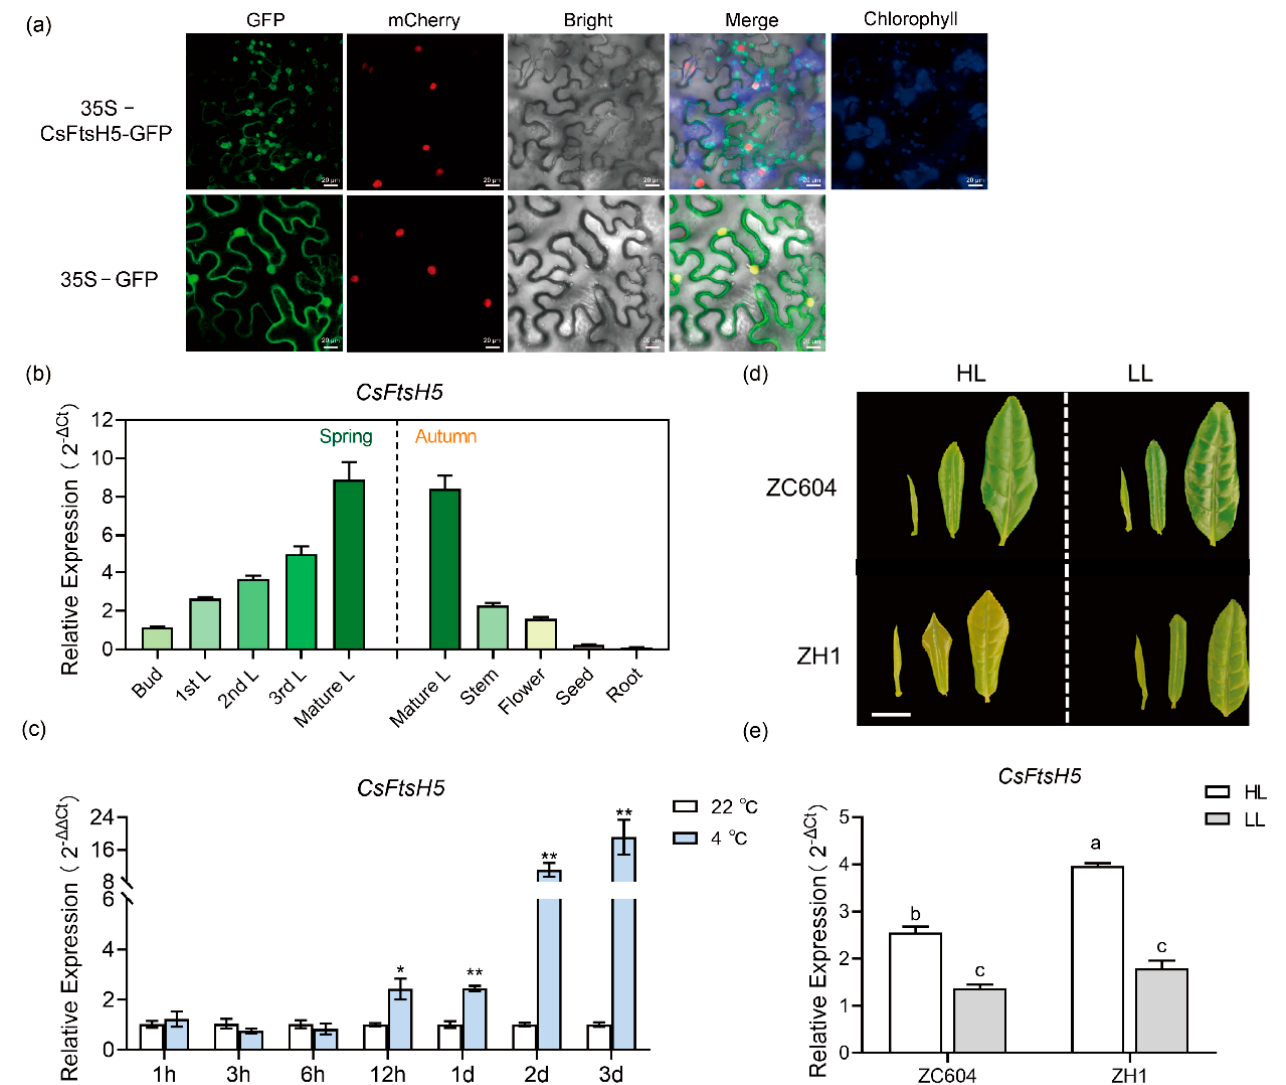
Figure 2. Expression profiles and sub-cellular localization of CsFtsH5 . ( a ) Sub-cellular localization of CsFtsH5 protein in H2B-RFP transgenic Nicotiana benthamiana leaves. The empty 35S-GFP was a positive control. Nuclei are indicated by the H2B-RFP (red), and the chloroplasts are shown in blue. Scale bar = 20 µm. ( b )The expression patterns of CsFtsH5 in tea plant tissues, including bud, 1st L, 2nd L, 3rd L, mature L, stem, flower, seed, and root. Samples were collected on April, 2020, and October, 2020. ( c ) The CsFtsH5 expression in tea plants under 22 °C and 4 °C treatments for 1, 3, 6, and 12 h, as well as 1, 2, and 3 d. Data are shown as the mean ± SEM ( n = 3). Asterisks indicate significant differences according to t -tests (* p < 0.05, ** p < 0.01). ( d ) The phenotype of 2 leaves and 1 bud of ZC604 and ZH1 under 100% and 10% sunlight conditions. Scale bar = 1 cm . ( e ) The expres- sion patterns of CsFtsH5 in leaves of the green-leaf cultivar of ZC604 cultivar and the yellow-leaf cultivar of ZH1 under 100% and 10% sunlight conditions. Means of three replicates and standard errors are presented; different letters above the column indicate a significant difference at p < 0.05 using LSD’s test. Values in ( b , e ) are expressed relative to the expression levels of the reference gene using the formula 2 −Δ Ct . Values in ( c ) are expressed relative to the expression levels of the 22 °C group using the formula 2 −ΔΔ Ct . CsPTB was used as a reference gene in expression analysis .